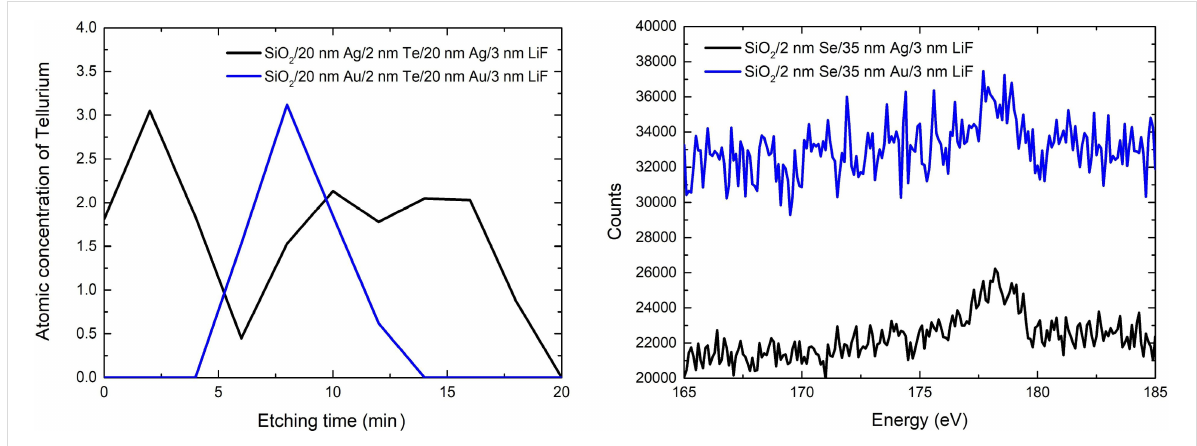
Figure 2: Left - Atomic concentration of Te atoms in the sandwich-like silver sample (black curve) as well as in the sandwich-like gold sample (blue curve). The etching time is equivalent to subsurface depth. Right – XPS spectra of 35 nm-thick Ag and Au layers deposited on top of 2 nm-thick Se